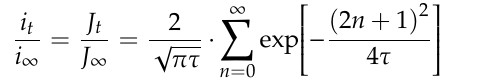
Figure 5. Schematic diagram of static hydrogen charging tensile test device.